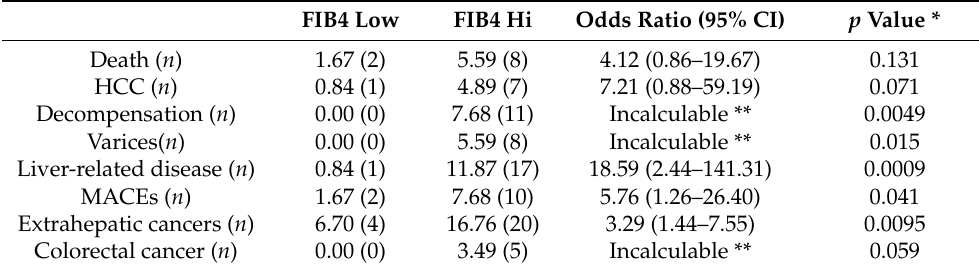
Table 2. Incidence rate per 1000 person-years and number of